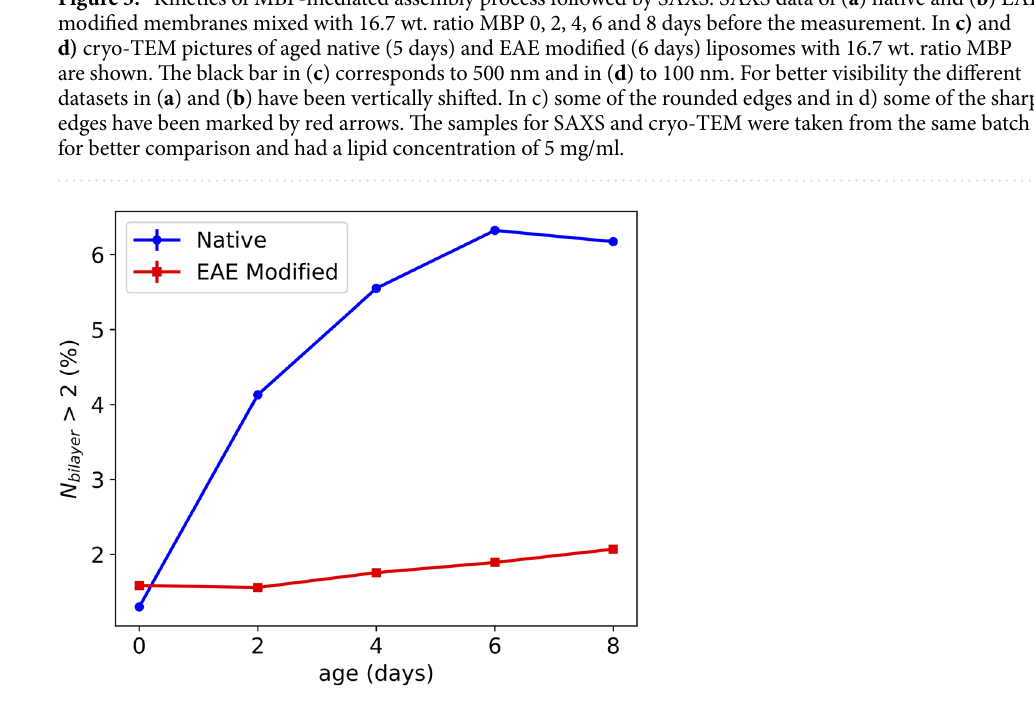
Figure 4. Number fraction of multilayers with a number of bilayers N > 2 in aging vesicles of native and EAE modified composition. The values have been extracted from the LUV + MLV fits shown in Fig.